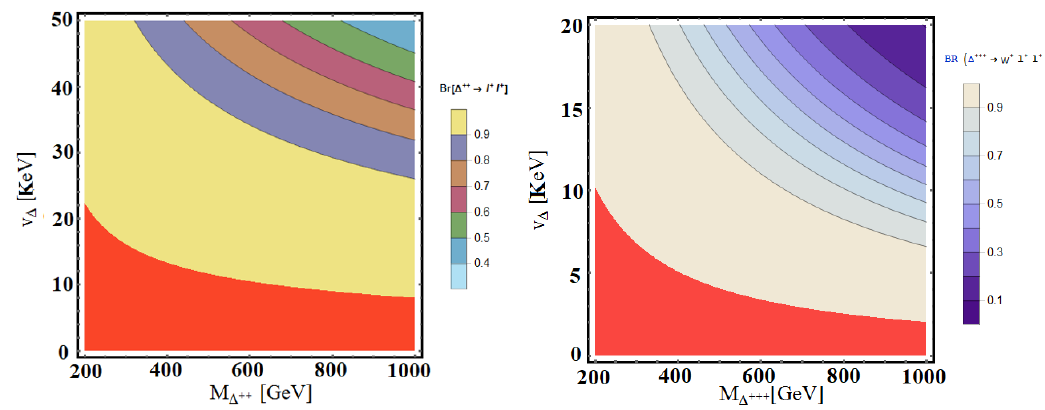
Figure 12 . Contour plot for branching ratio Br((cid:1) (cid:6)(cid:6) ! l (cid:6) l (cid:6) ) (left panel) and Br((cid:1) (cid:6)(cid:6)(cid:6) ! W (cid:6) l (cid:6) l (cid:6) ) (right panel) in v (cid:1) - M plane. Branching ratio scale is shown in (cid:1) (cid:6)(cid:6) right side of the (cid:12)gure. Red shaded zone in both (cid:12)gure corresponds to Br((cid:1) (cid:6)(cid:6) ! l (cid:6) l (cid:6) ) or Br((cid:1) (cid:6)(cid:6)(cid:6) ! W (cid:6) l (cid:6) l (cid:6) ) (cid:24)